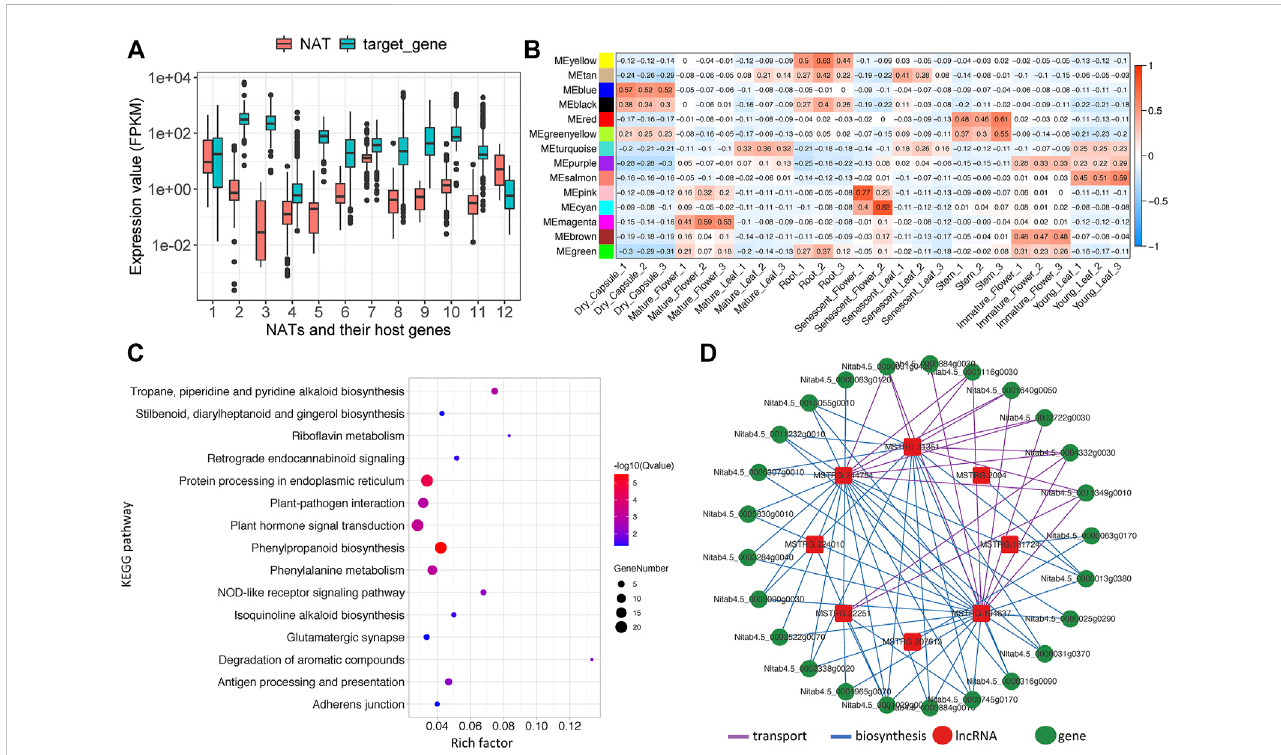
FIGURE 5 Analysis of lncRNAs associated protein-coding gene network related to nicotine pathway. (A) Expression boxplot of 12 NATs and their corresponding host genes, (B) Module-sample associations. Each row corresponds to a module eigengene, a column to a sample. Each cell contains the corresponding correlation, (C) KEGG enrichment plot of topping respond genes (D) The lncRNA-coding gene subnetwork related to the nicotine pathway.